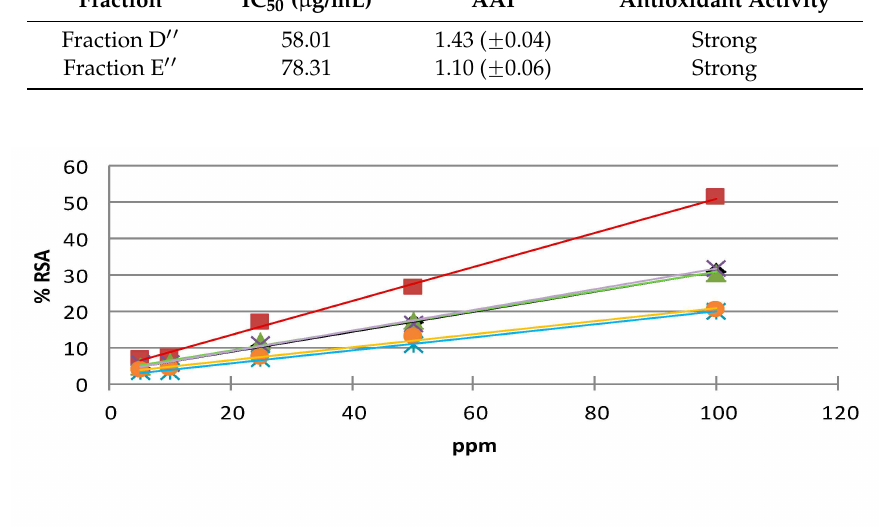
Figure 7. DPPH radical scavenging activity of the dichloromethane extract and its fractions from citrus by-products: Fraction E 1 showed the highest scavenging activity; Fractions F 1 and G 1 showed the same antioxidant activity as the DCM extract; Fractions H 1 and I 1 showed the lowest scavenging activity.